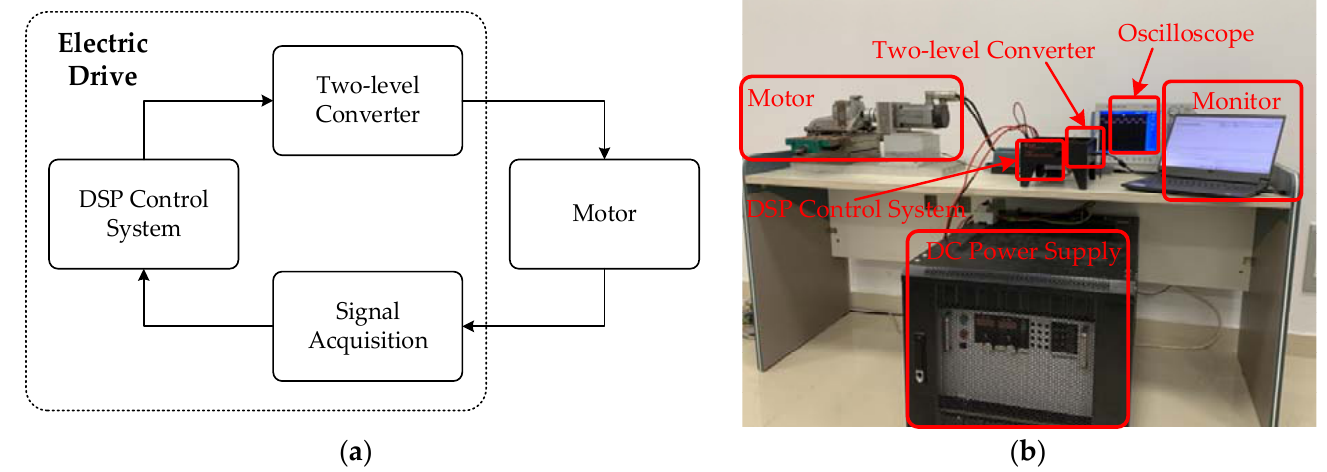
Table 1. Parameters of experiment setup.